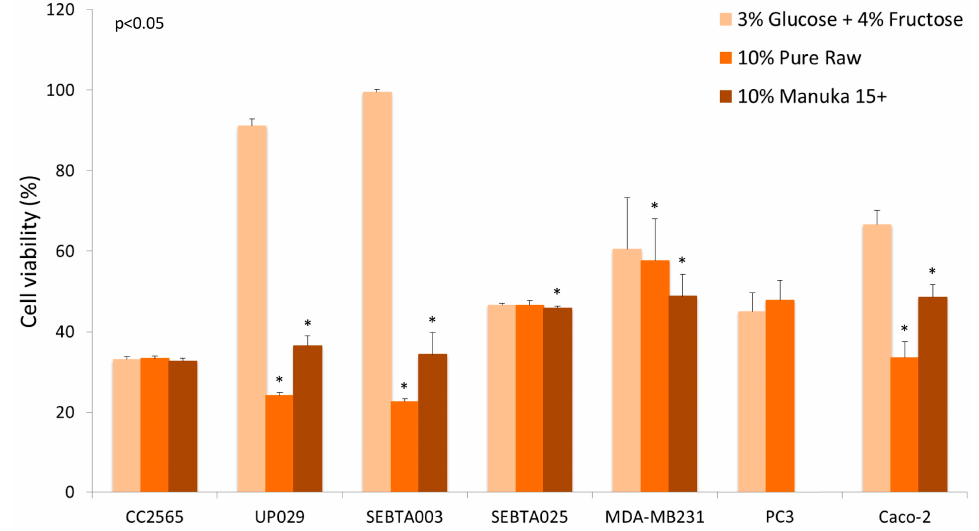
Figure 2. The effect of manuka 15+ honey and pure raw unprocessed honey (USA) on cell viability, using MTS assay.